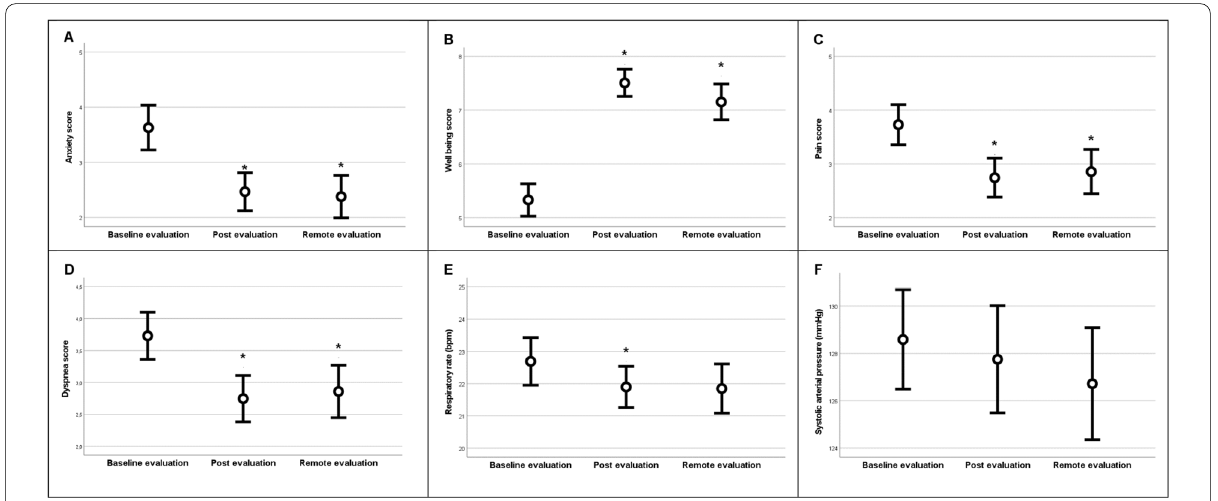
Fig. 2 Effect of corporeal rehabilitation care on psychological [stress ( A ), well‑being ( B )], and functional [pain ( C ), dyspnea ( D ), respiratory rate ( E ) and systolic arterial pressure ( F )]